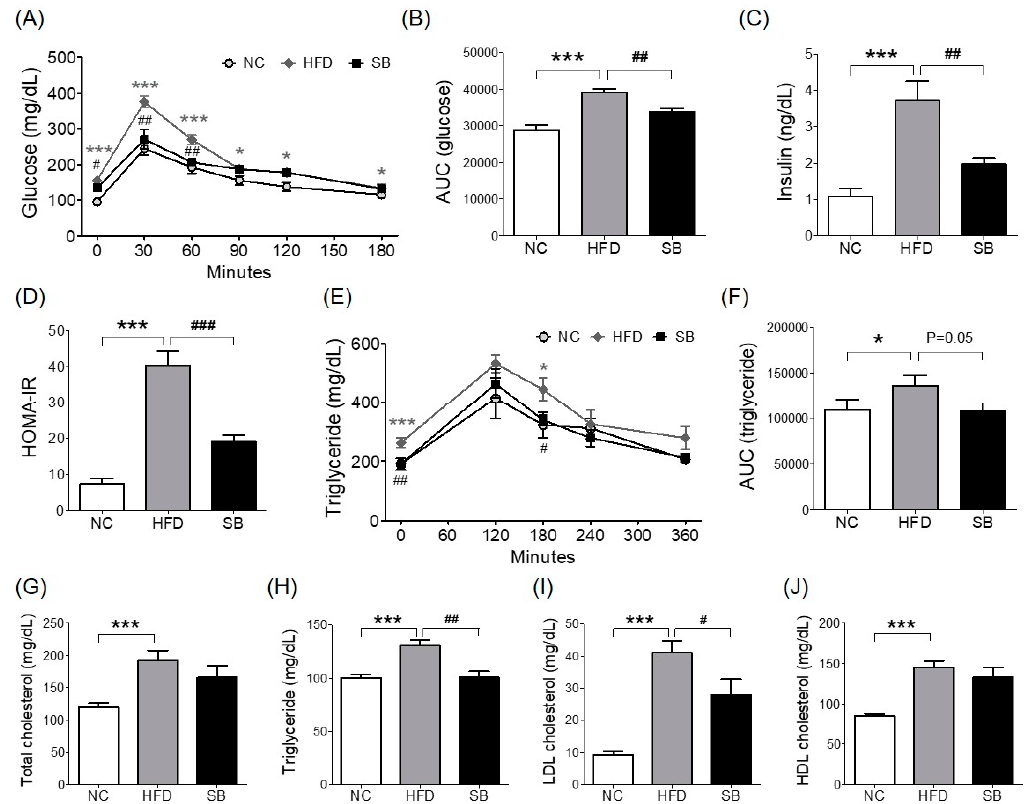
Figure 2. Effects of SB on oral glucose tolerance test (OGTT) and area under curve (AUC) ( A , B ), fasting insulin ( C ), HOMA-IR ( D ), oral fat tolerance test (OFTT) and area under curve (AUC) ( E , F ), serum total cholesterol, triglyceride, LDL cholesterol, and HDL cholesterol ( G – J ). n = 6 in each groups. Data shown as mean ± SEM. * p < 0.05, *** p < 0.001, HFD compared with NC; # p < 0.05, ## p < 0.01, and ### p < 0.001, HFD compared with SB.